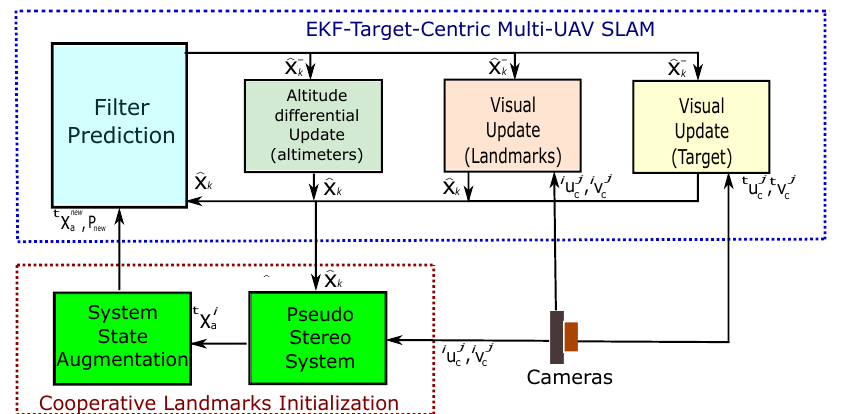
Figure 3. Block diagram showing the EKF-SLAM architecture of the proposed